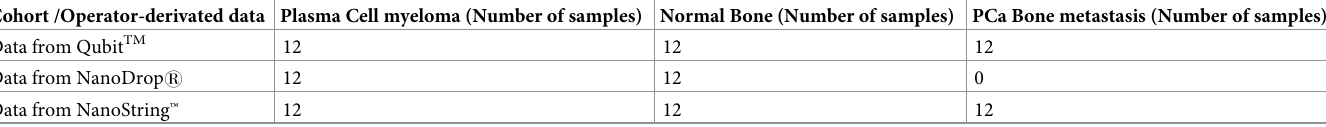
Table 1. Data set reference and cohorts (source of